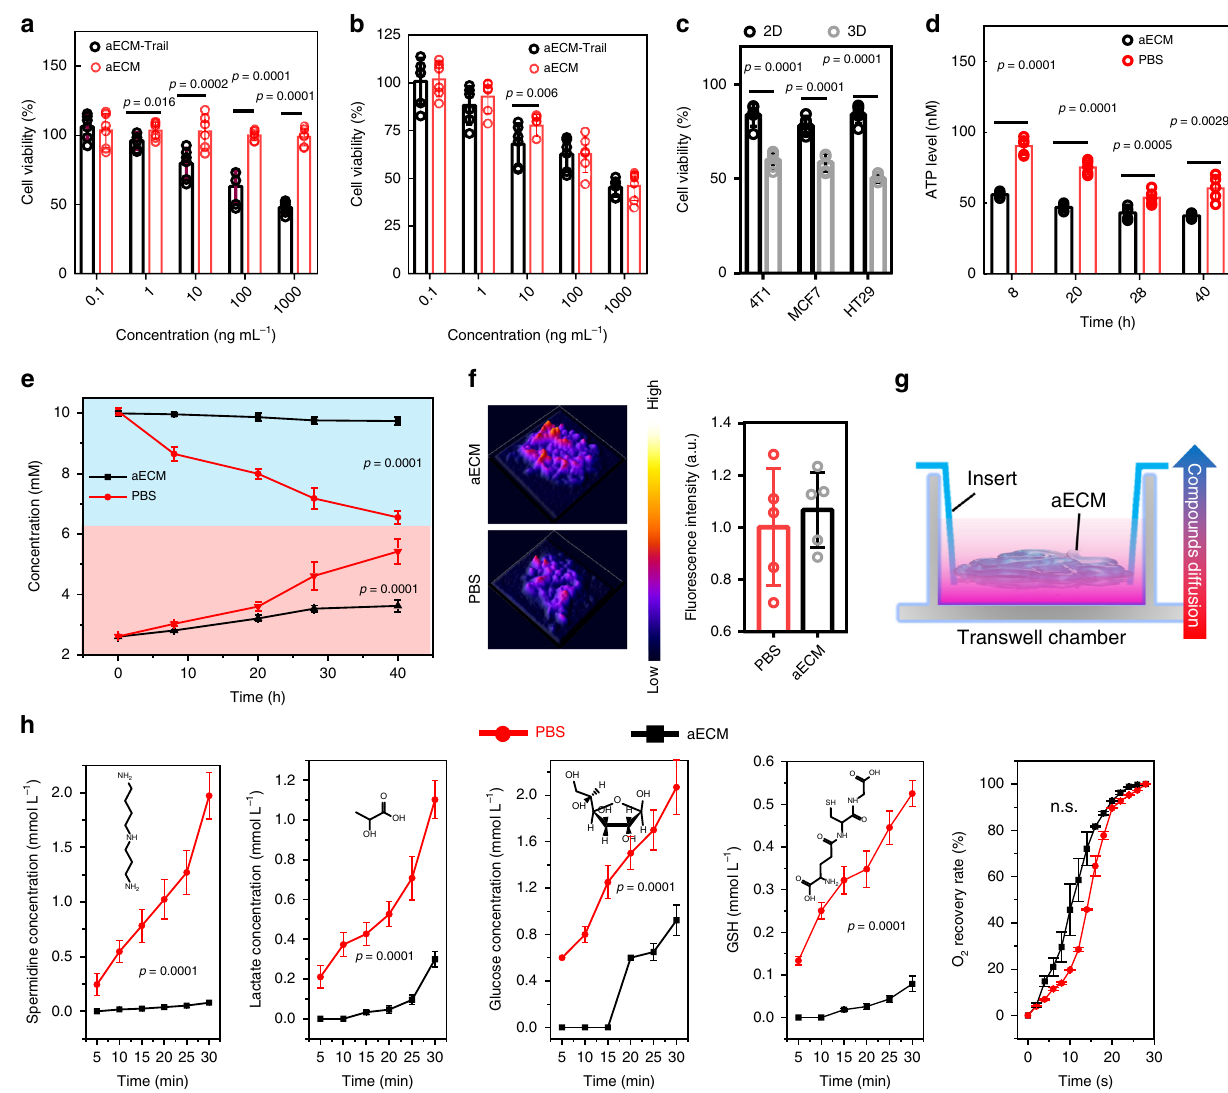
Fig. 2 Anti-cancer mechanism of aECM. a Cytotoxicity of different concentrations of aECM or aECM-Trail (0.1 – 1000 ng mL − 1 ) towards CT26 cells. Six biological replicates are shown. b Cytotoxicity of different concentrations of aECM or aECM-Trail (0.1 – 1000 ng mL − 1 ) towards CT26 MTS. CT26 MTS were treated with aECM or aECM-Trail for 24 h. Six biological replicates are shown. c Cytotoxicity of aECM towards 2D cell culture system and 3D MTS model in 4T1, MCF-7, and HT-29 cells for 24 h. Five biological replicates are shown. d ATP level in CT26 MTS after being treated with aECM or PBS. The ATP levels were measured at the different time points during the treatment. Five biological replicates are shown. e Real-time glucose and lactate concentrations in the culture medium of aECM or PBS treated CT26 MTS. Six biological replicates are shown. The upper curves represent glucose, and the lower curves represent lactic acid. f Oxygen content in CT26 MTS after being treated with PBS or aECM. ROS-ID was used to visualize the hypoxia levels in CT26 MTS. Five biological replicates are shown. g Schematic diagram of the diffusion assay based on Transwell insert. A high concentration solution was added in the lower chamber and DI water was placed in the upper chamber. aECM or collagen was coated on the porous membrane. h The effect of aECM coating on suppressing mass transports (spermidine, lactate, glucose, glutathione, and O 2 ). Collagen-coated Transwell inserts were set as a control (black). Three biological replicates are shown. Signi fi cance between two groups ( a – f , h ) was calculated by using two-tailed Student ’ s t- test. The mean values and SD are